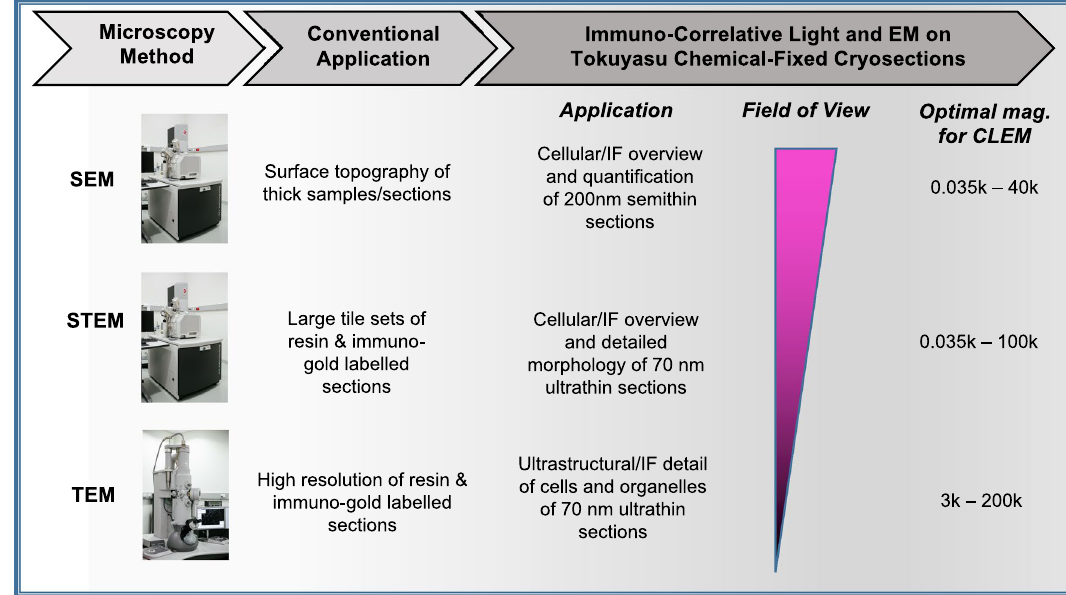
Figure 8. Conventional EM microscopy application compared with i CLEM on Tokuyasu prepared sections. Field of view depicts the slight overlap in magnification present between each microscopy method (SEM, STEM, TEM), and the overall decrease in field of view with the transitions from SEM-TEM resolution. The optimal magnification for our i CLEM technique for each microscopy method is shown in the right-most column, and may differ from magnification used for conventional EM